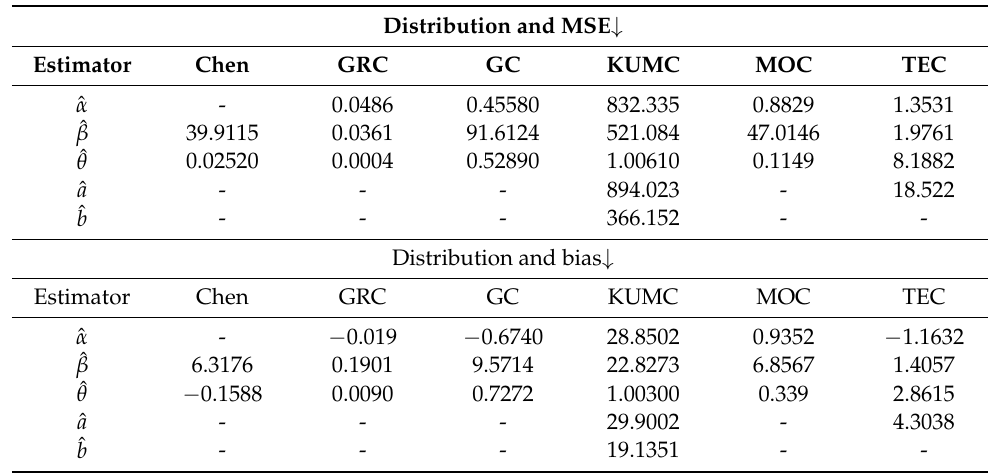
Table 14. Results for samples generated from the GRC distribution with n =